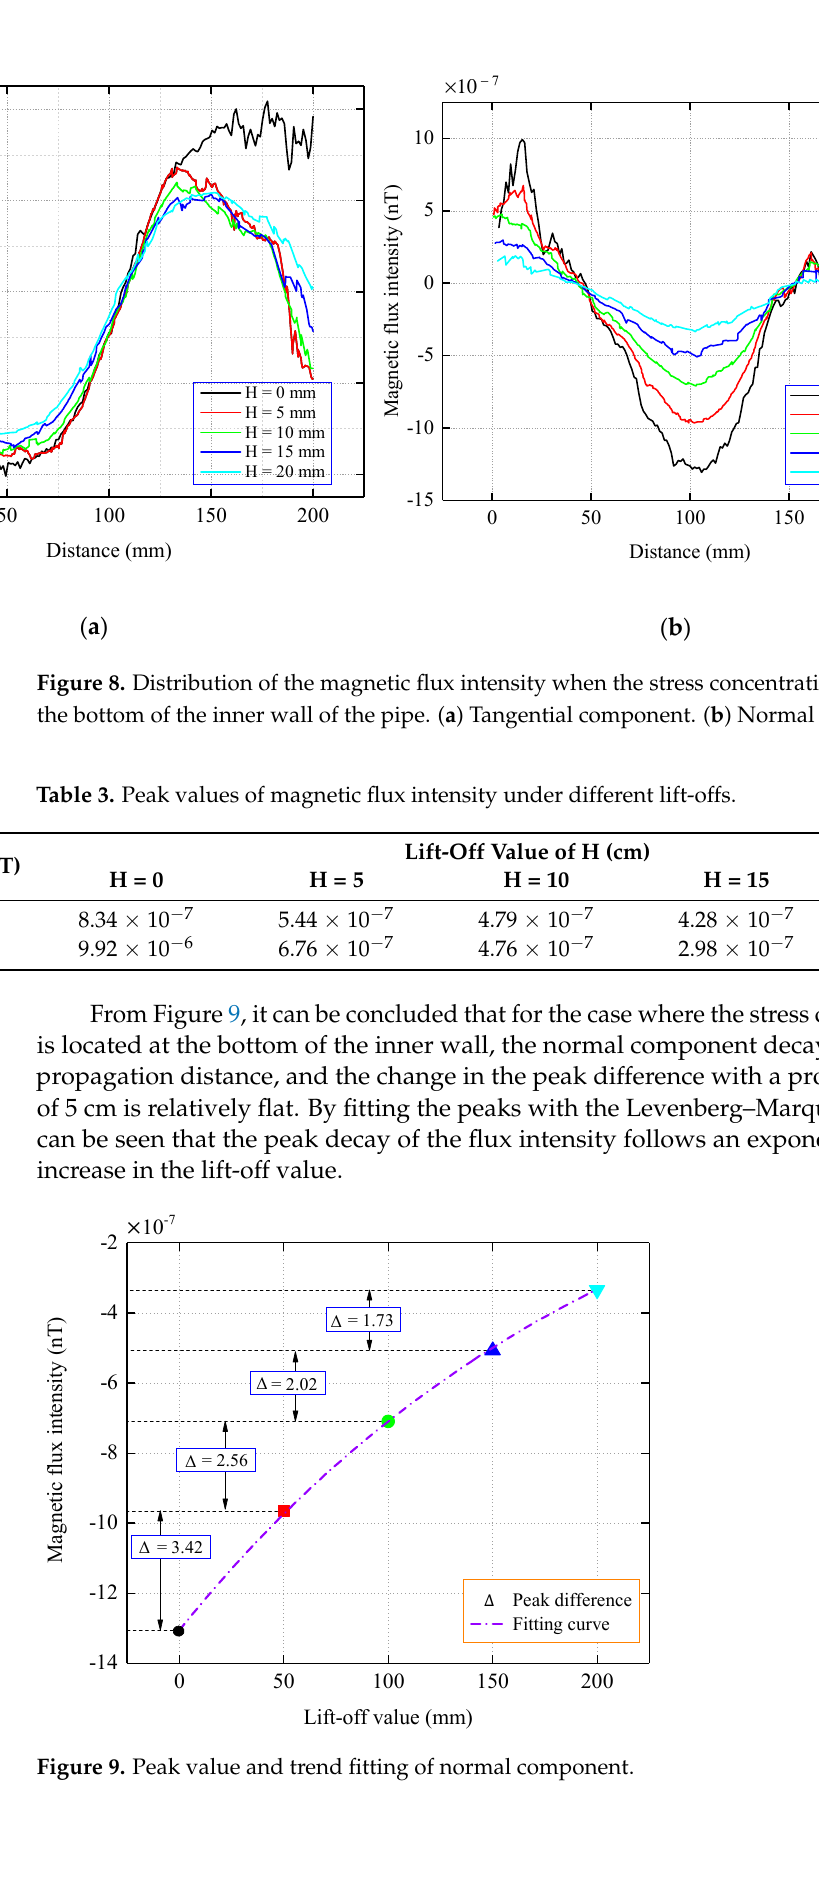
Figure 9. Peak value and trend fitting of normal component.